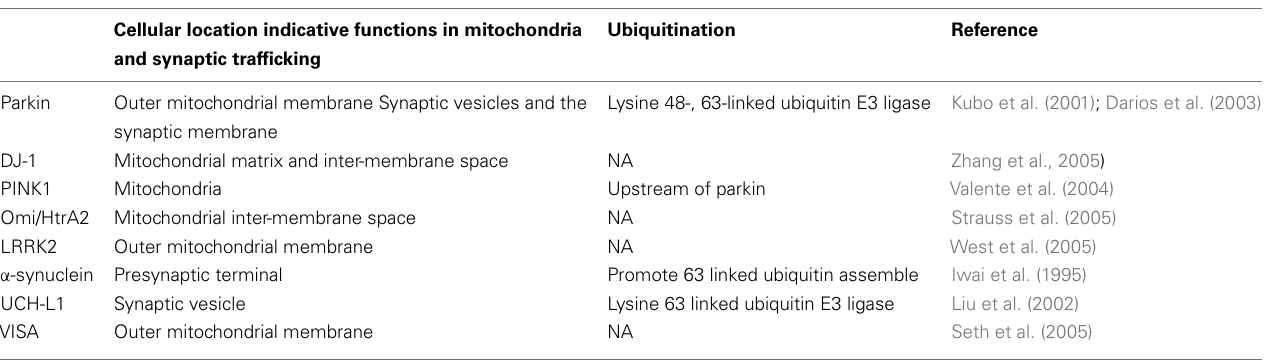
Table 1 | Cellular localization and functions PARK and related genes Cellular location indicative functions in mitochondria and synaptic